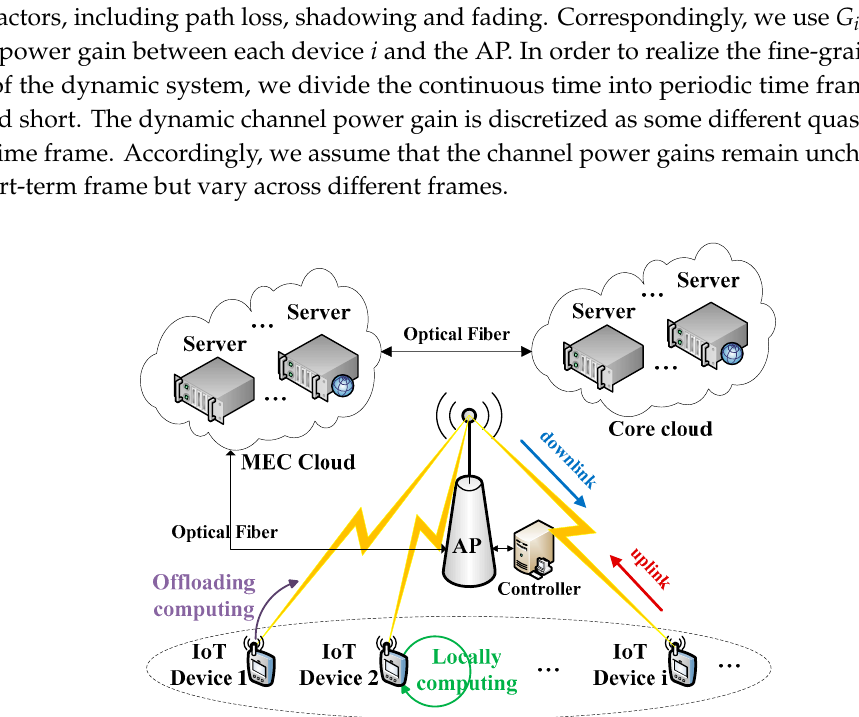
Figure 1. The system model with multiple devices and dynamic channels.